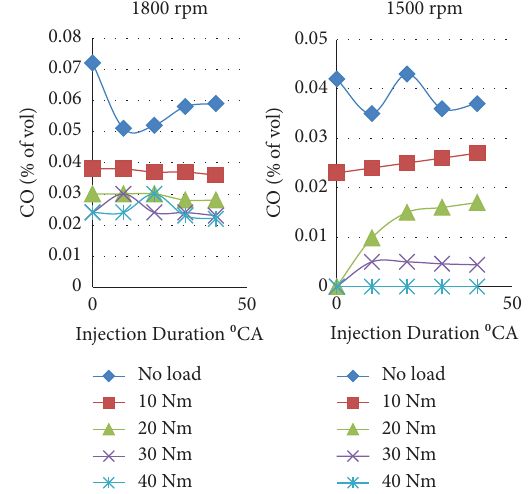
Figure 7: Carbon monoxide emission for diferent H engine speeds of 1800rpm and 1500rpm.